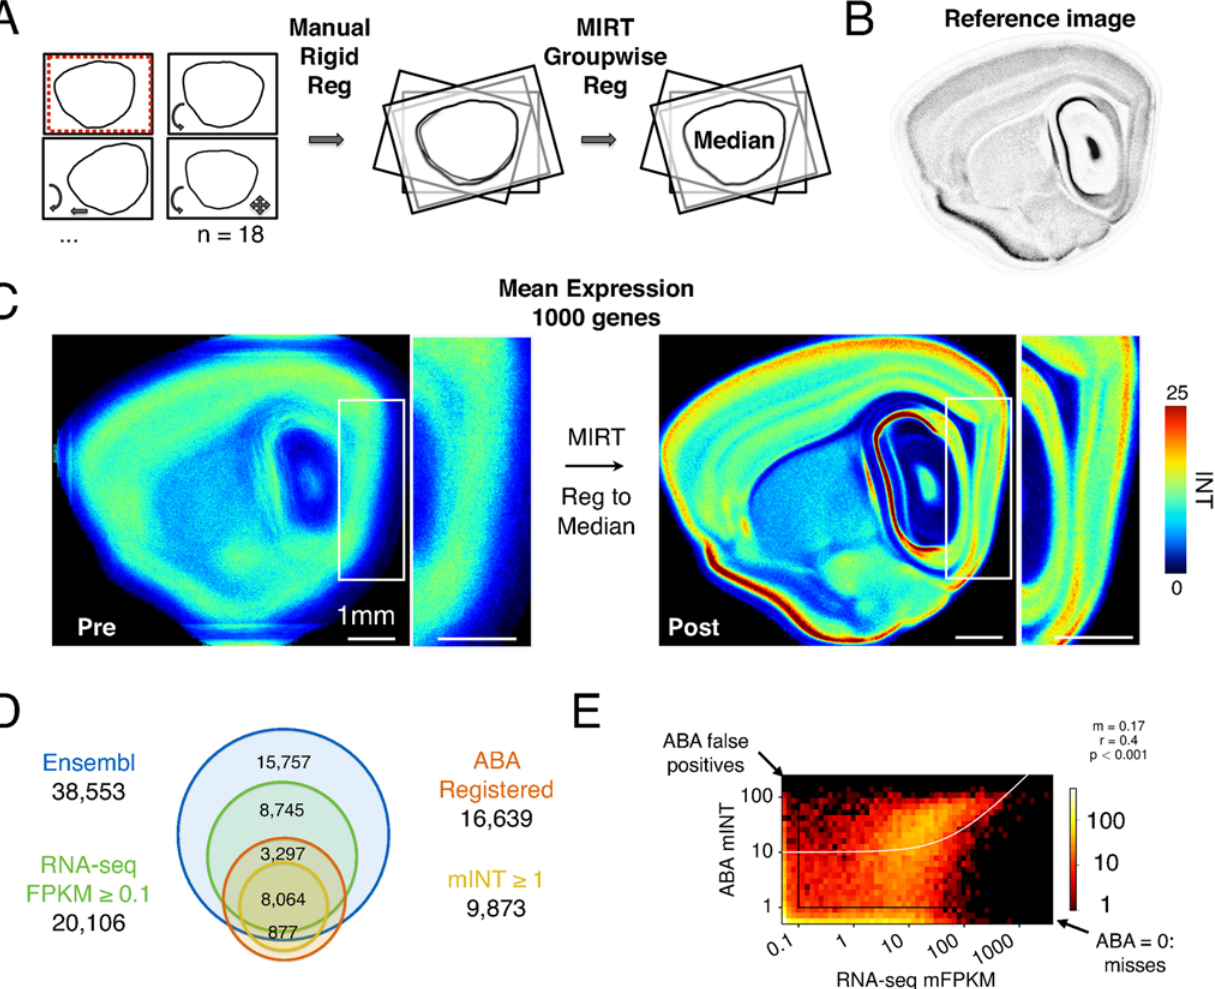
Figure 1. Large-scale extraction of MEC gene expression data. (A) Generation of a reference image (Im ref ) for image warping. Images were selected (left), aligned to a template image (red dotted line) by scaling, rotation and translation (Manual Rigid Reg, centre), then registered to each other using non- linear deformation (MIRT Groupwise Reg, right). Im ref was defined as the median of the resulting images (Median, right). (B) The central reference image (Im refC , S1A Fig.). (C) Image registration reveals laminar organization of gene expression. Images show the mean pixel intensity (INT) for 1000 ABA expression images before (left) and after (right) registration of the corresponding pre-processed ISH image to Im refC . Colors represent pixel intensity (Colormap adapted from the Matplotlib ‘ jet ’ colormap). White boxes outline the area corresponding to the MEC, shown at higher magnification. (D) Venn diagrams indicate the number of genes detected as expressed in the MEC using RNA-seq analysis (Ensembl v73) and/or our re-registered ABA data set. (E) 2D histogram indicating the number of genes with a particular FPKM and mINT, represented using a log scale (right). White line is the linear regression fit, which indicates that RNA-seq and ABA expression are positively correlated. Data were averaged across the dorsal and ventral region. Data with zero values are included in the first histogram bin.